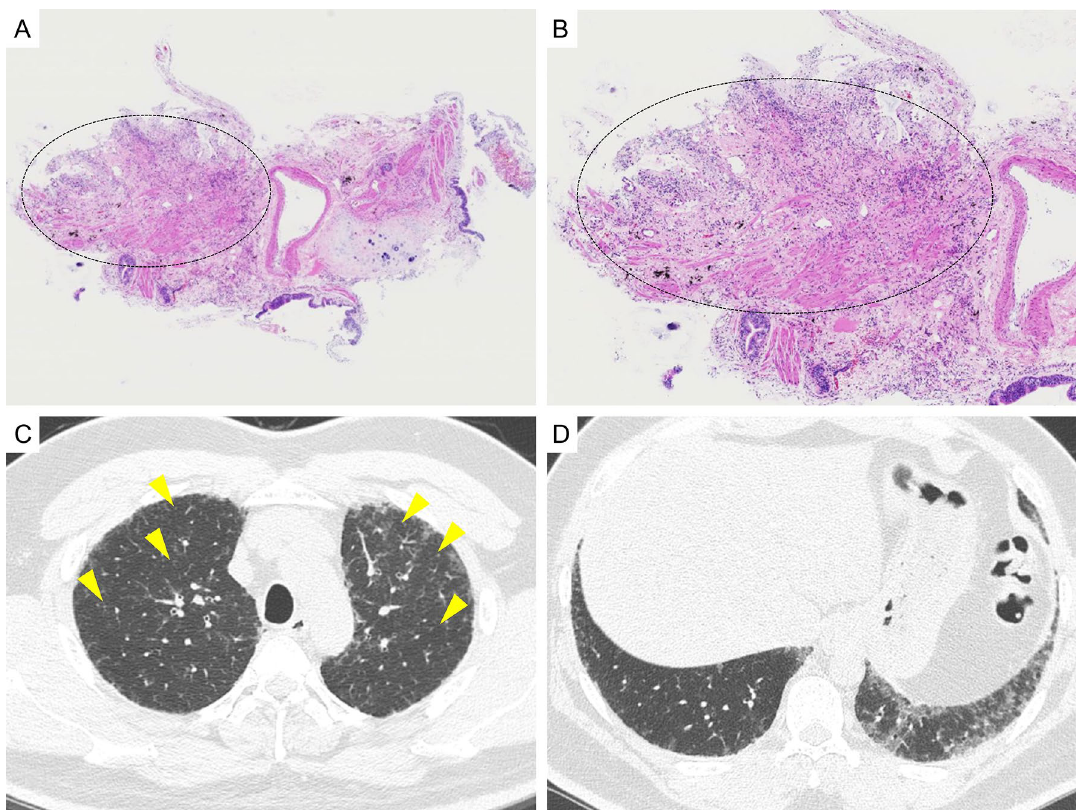
Figure 2. A case in which the pathology diagnosis by transbronchial lung cryobiopsy (TBLC) was inconsistent with the diagnosis of MDD. ( A ), ( B ): pathology by TBLC. Dense fibrosis with architectural destruction were observed (blue curcle). However, normal alveolar structure beside the dense fibrosis was not observed in this specimen. ( C ), ( D ): high-resolution computed tomography (HRCT). Centrilobular nodules were observed in the upper lobes of the lung (orange arrow). In addition, reticular shadows or honeycombing which suggests UIP pattern were not